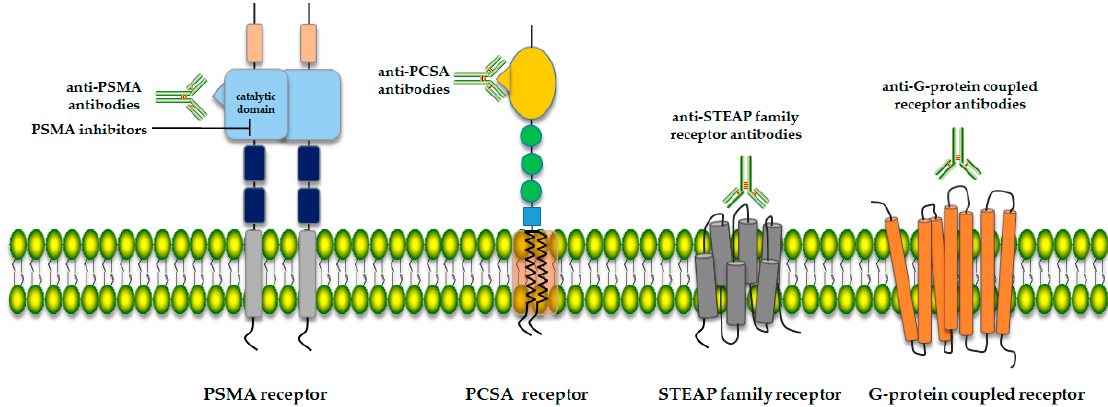
Figure 1. Schematic structure of selected prostate cell membrane receptors as potential prostate cancer therapy targets.